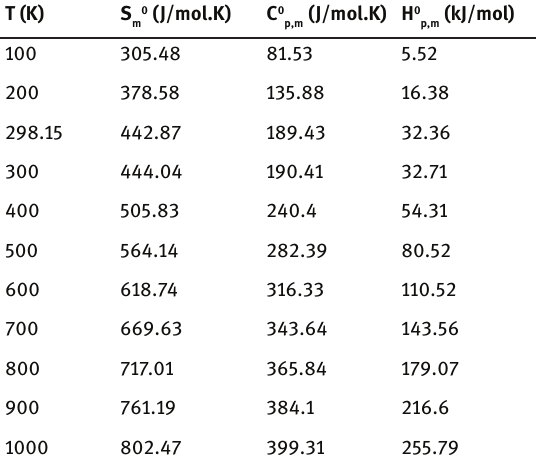
Table 6 : Thermodynamic properties for N -acetylisatin obtained by B3LYP/6- 311++G(d,p)